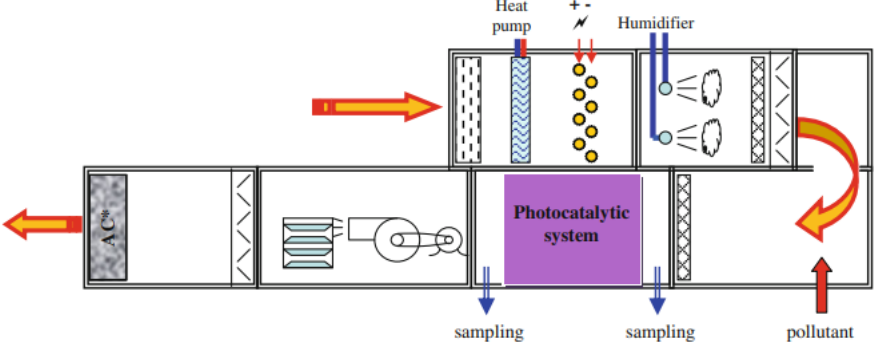
Figure 14. Design of an industrial-scale air purifier for the purification of exhaust gases from an animal shelter. (Reprinted/adapted with permission from Ref.